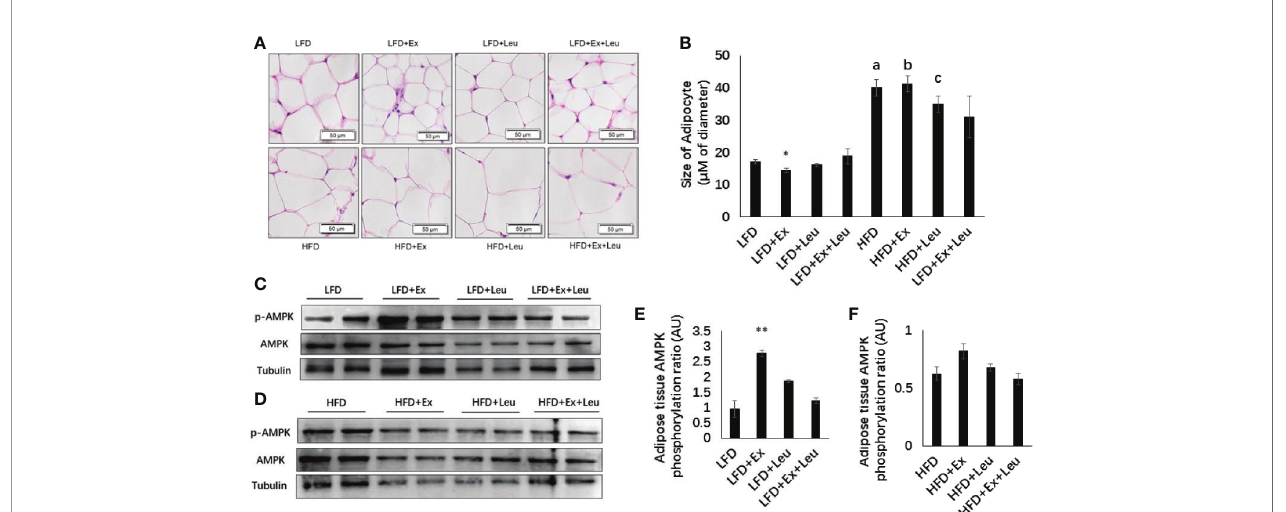
FIGURE 3 | Exercise reduced the size of adipocytes and enhanced AMPK phosphorylation under LFD. C57BL/6J male mice of 5 – 6 weeks were fed with LFD or HFD. Leucine with a concentration of 1.5% and/or moderate intensity exercise was added in the 10th week and administrated for 4 weeks. (A) Adipose tissue histology. The sections of adipose tissue were stained with hematoxylin and eosin. (B) Quanti fi cation of the adipocyte size. For (C, D) , the levels and phosphorylation states of AMPK in the adipose tissue were determined using western blots. For (E, F) , quanti fi cation of AMPK phosphorylation (arbitrary units) for (C, D) , respectively. The data are mean ± s.d. (error bars), n = 6 mice per group. *p < 0.05; **p < 0.01, LFD versus LFD+Ex; a, p < 0.01, LFD versus HFD; b, p < 0.01, LFD + Ex versus HFD + Ex; c, p<0.05, LFD + Leu versus HFD +